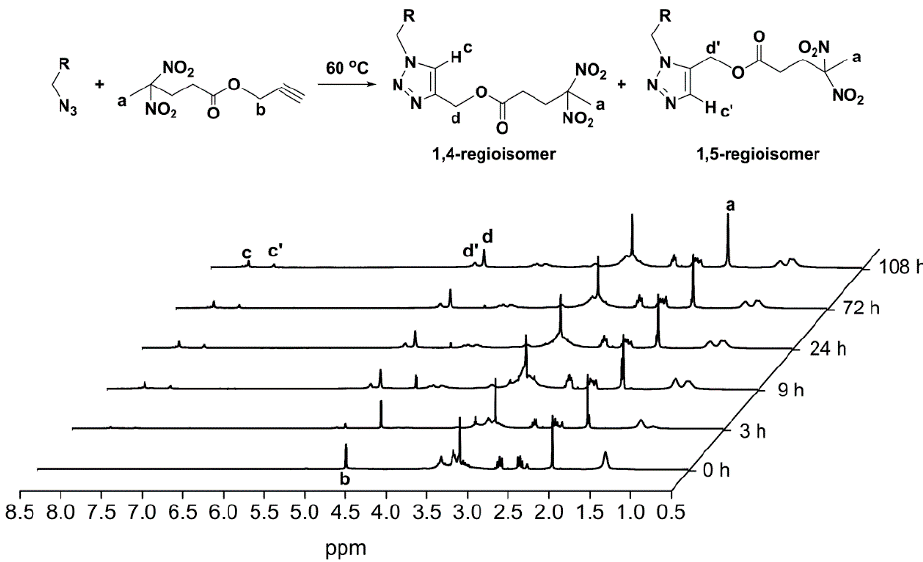
Figure 2. 1 H NMR spectra as a function of the reaction time of Cu-free 1,3-DPCA reaction of PDNP ( n = 1) and PGT prepolymer carried out under the bulk condition at 60 °C. The R group in the reaction scheme above is the backbone of the PGT prepolymer.